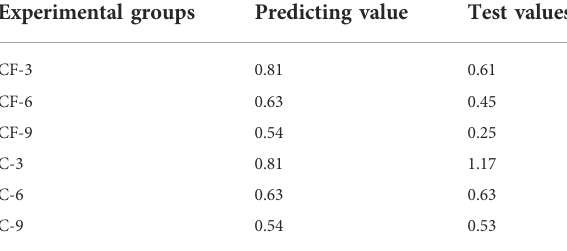
TABLE 4 Comparison of nominal bond stress. Experimental